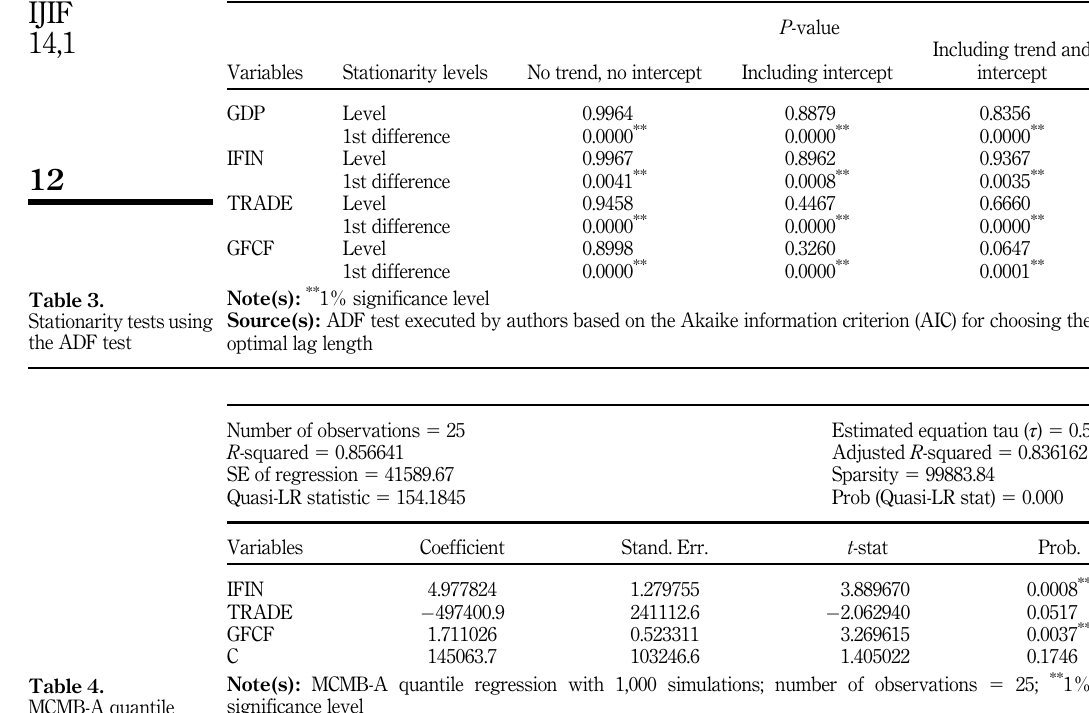
Table 4. MCMB-A quantile regression